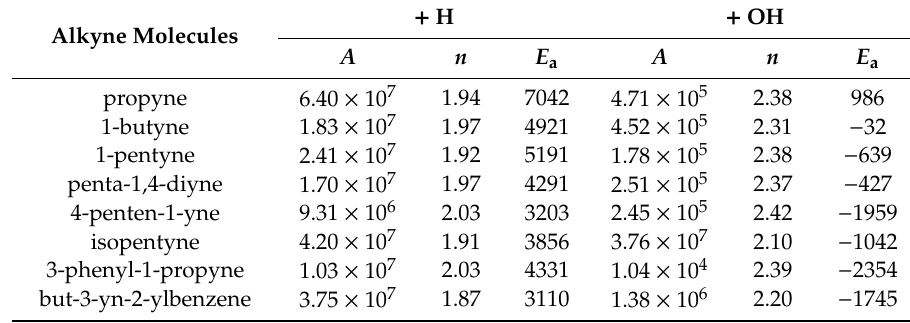
Figure 9. Computed rate constants for the abstraction reactions with OH at propargyl site. Table 4. Fitted Arrhenius coefficients of the studied reactions in k ( T ) = AT n exp(- E a / RT ). ( A : cm 3 mol − 1 s − 1 ; E a : cal mol − 1 ).